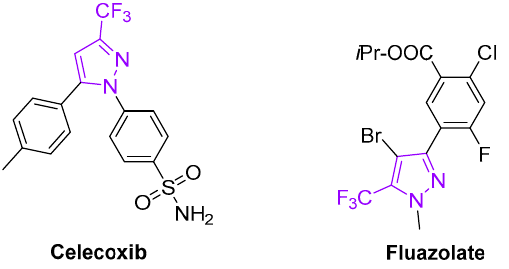
Figure 2. Bioactive trifluoromethyl pyrazole derivatives.